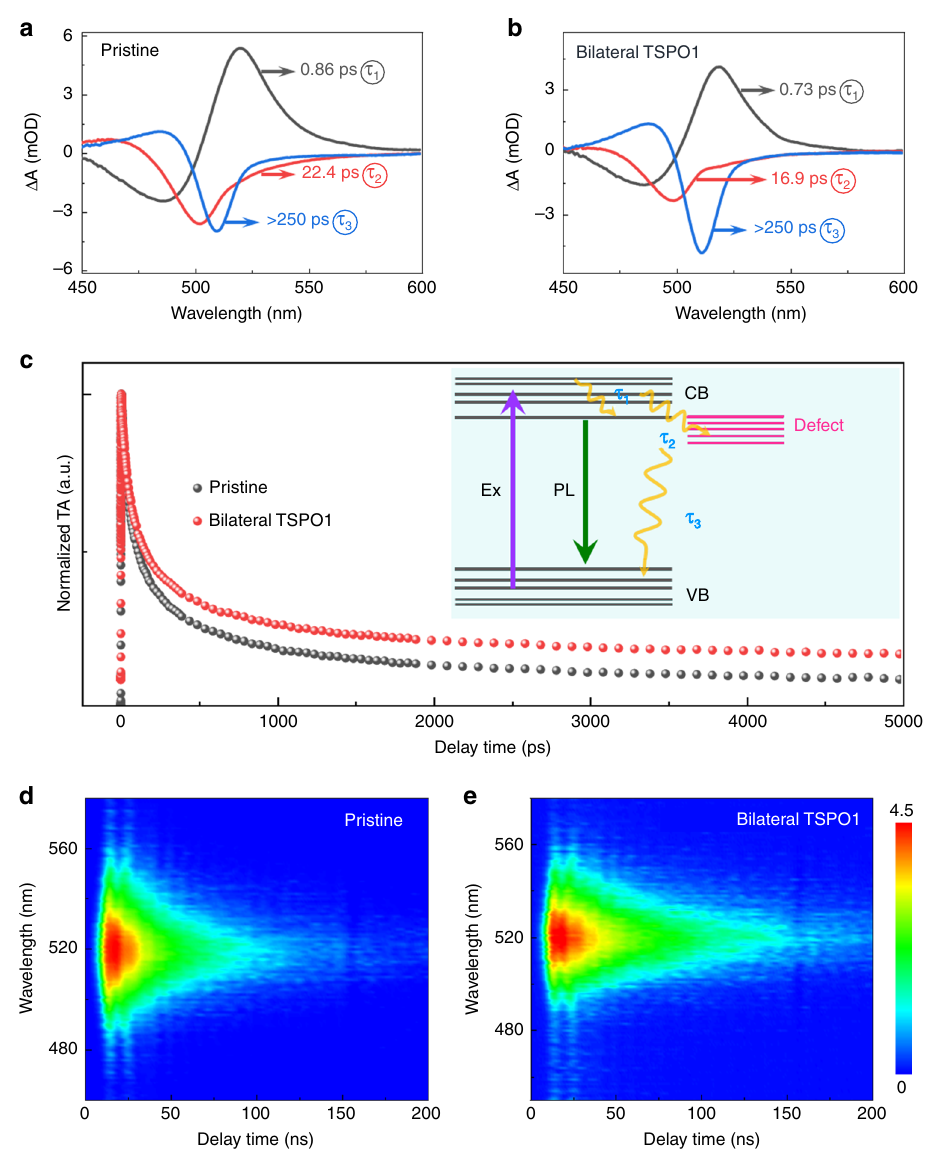
Fig. 3 Exciton dynamics comparison of QD fi lms with different passivation states. a , b Decay-associated spectra for pristine and TSPO1-passivated QD fi lms. The processes of intraband hot-exciton relaxation ( τ τ τ 1 ), exciton trapping to the band-edge trap states ( 2 ), and exciton recombination ( 3 ) was extracted to study the exciton dynamics. c Comparison of transient TA spectra with an excitation fl uence of 5 μ J cm − 2 . Inset: Schematic illustration of the photoinduced relaxation processes involved in the QD fi lms. Two-dimensional contour image of time-resolved PL delay for ( d ) pristine and ( e ) bilateral TSPO1-passivated QD fi lms. Source data are provided as a Source Data fi